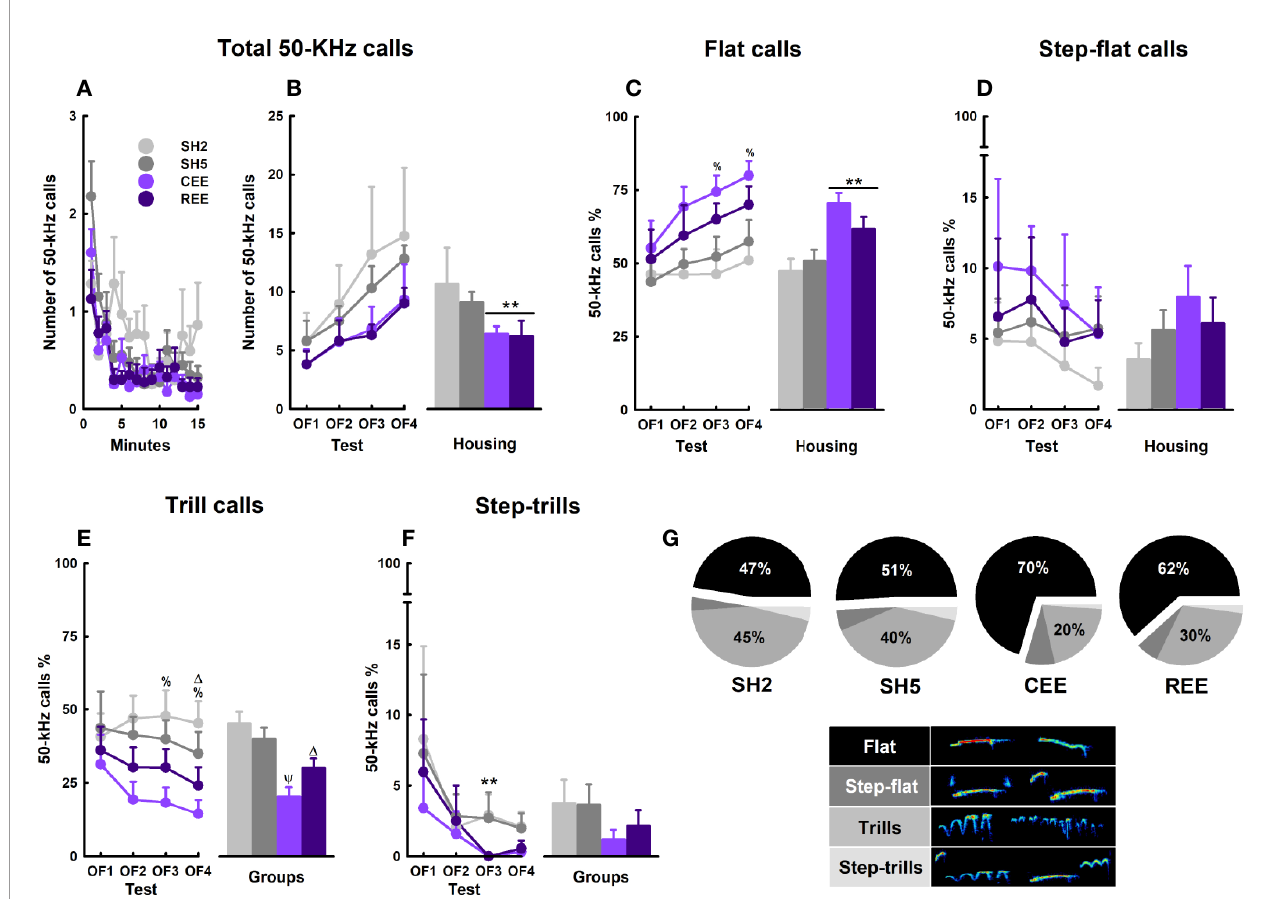
FIGURE 7 | Ultrasonic vocalizations kinetics and subtypes in the open- fi eld test. Total number of 50-kHz calls over minutes (A) and days (B) . Percentages of fl ats (C) , step- fl ats (D) , trills (E) , and step-trills (F) . Distribution of 50-kHz calls subtypes within each group (G) and their respective exemplary sonograms (lower panel). Data correspond to frequencies (A, B) and percentages (C – G) expressed as mean ± SEM. SH2: Standard housing with two rats. SH5, standard housing with fi ve rats. CEE, continuous environmental enrichment; REE, restricted and unpredictable environmental enrichment. Symbols correspond to single, pairwise-comparisons between groups. CEE and REE vs. SH2 and SH5: ** p < .001. CEE vs. SH2: % p < .05. CEE vs. SH2 and SH5: Y p < .05. REE vs. SH2: D p < .05. For pie graphs, see main text for